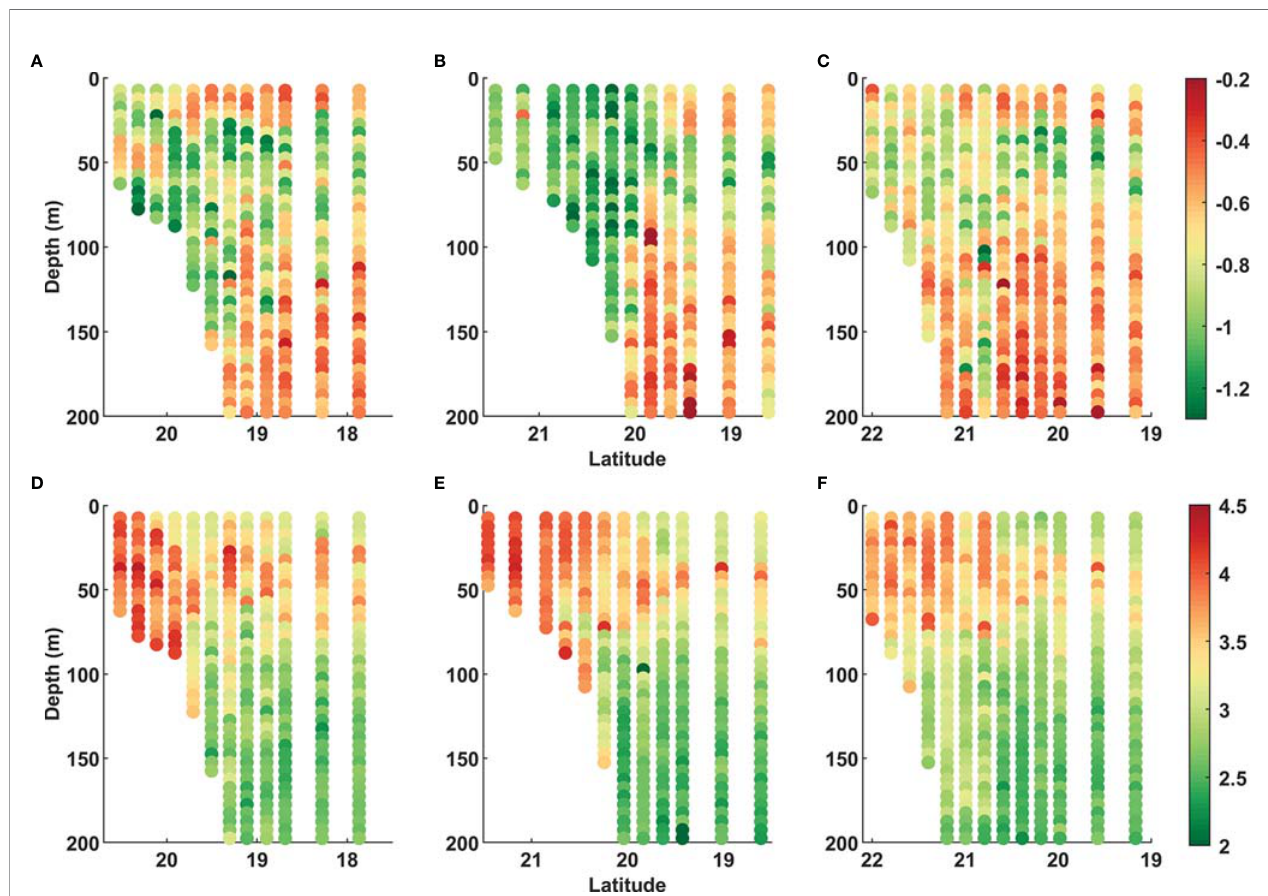
FIGURE 7 | Slopes (A – C) and intercepts (D – F) of NBVS in transect S1 (left panel), S2 (middle panel), and S3 (right